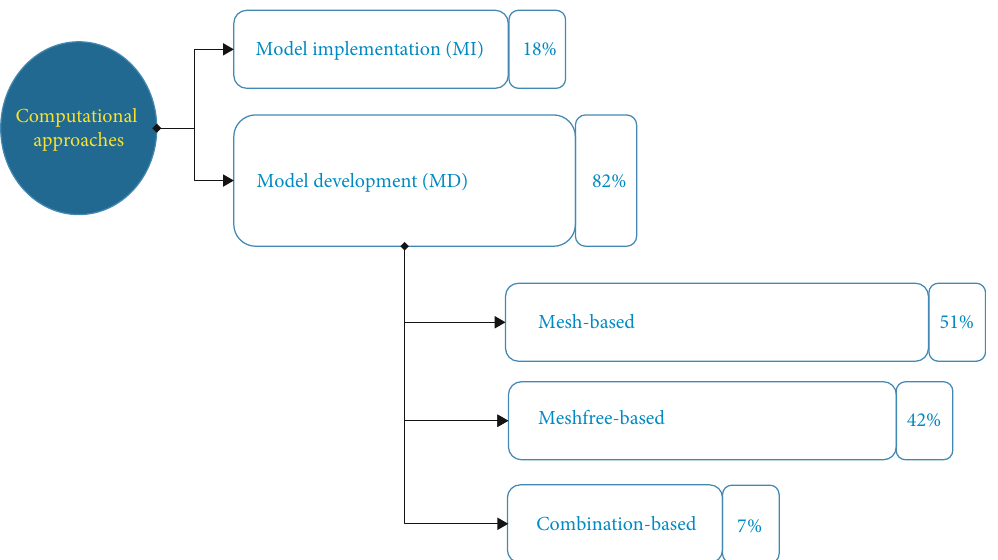
Figure 2: Distribution of computational approaches (MD and MI) and associated techniques for MD approach in the